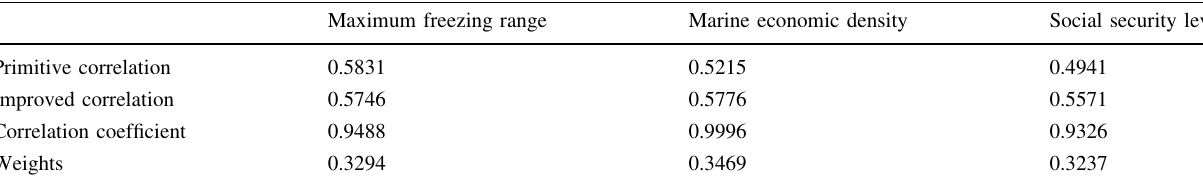
Table 12 Grey correlation analysis results for indicators of sea ice